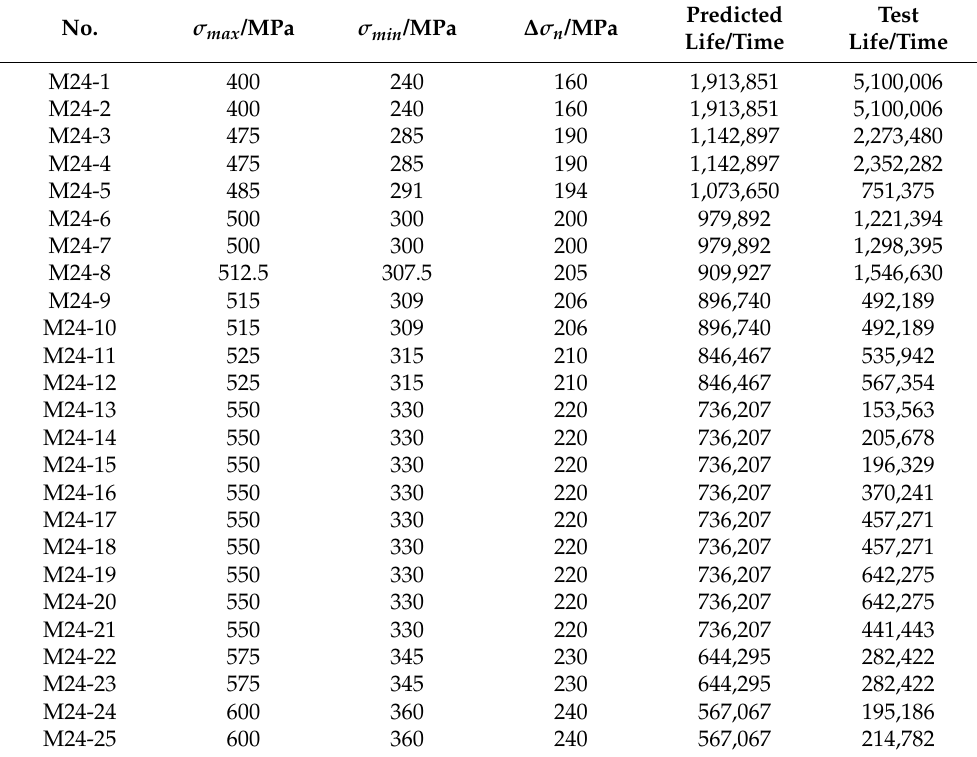
Table 11. Estimated fatigue life of M24 high-strength bolt ( a 0 = 0.02 mm).